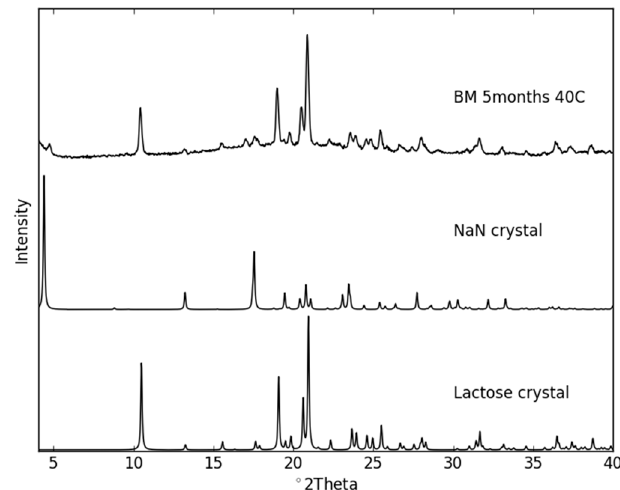
Figure 8. Recrystallization XRPD pattern of ball milled co-amorphous NaN-Lact after five months storage at 40 °C, showing the predominant crystalline powder pattern of Lact and a small contribution of crystalline NaN. NaN crystal and Lact crystal diffraction patterns were simulated from the known crystal structures (CSD refcodes: ASUBUL for NaN and BLACTO for Lact).